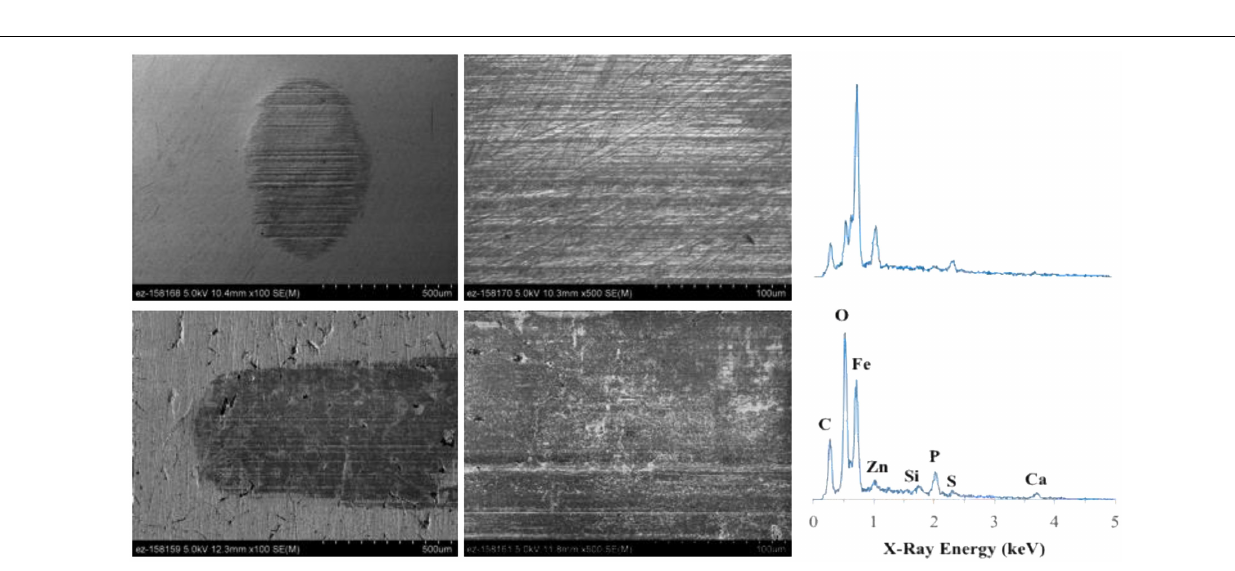
FIGURE 4 | SEM micrographs and EDS spectra of worn surfaces lubricated with EF + 0.52% [P 8888 ][DEHP] + 0.4% ZDDP . Top : steel ball surfaces. Bottom : cast iron flat